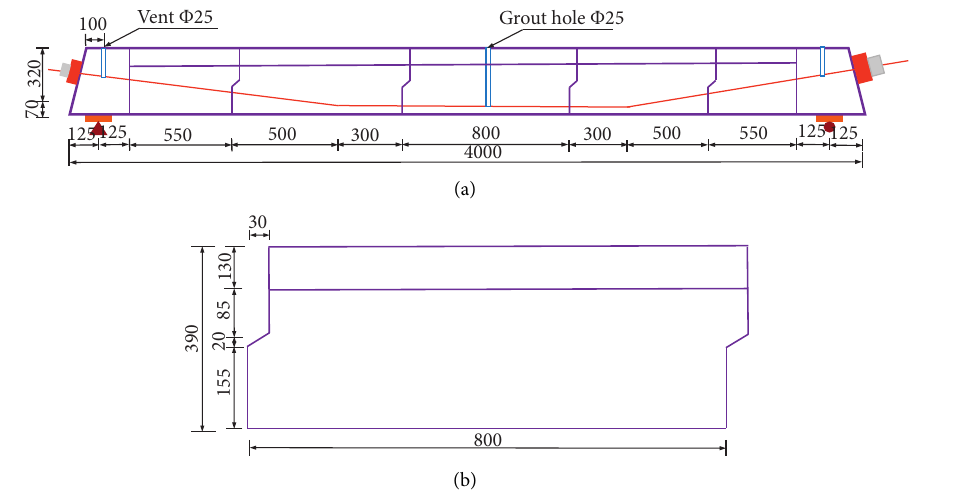
Figure 19: PCS girders with corbel joints. Table 3: Characteristics of analysis cases.